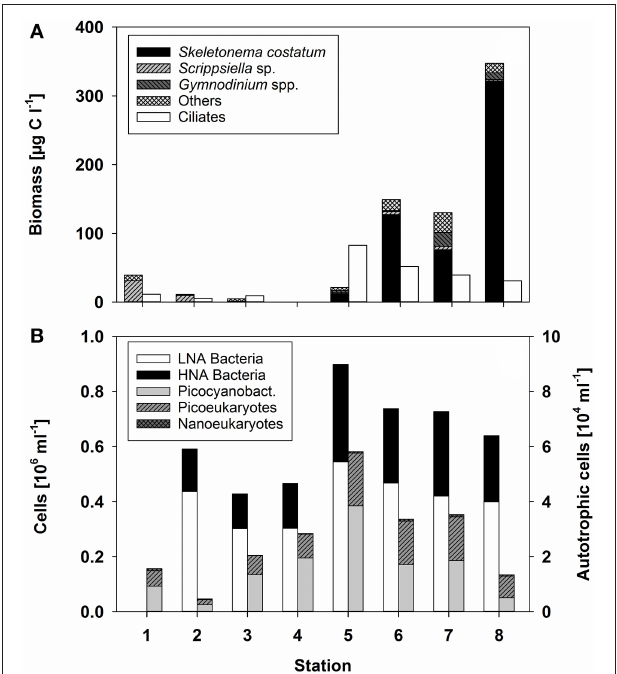
FIGURE 2 | (A) Biomass of the dominant phytoplankton taxa or taxonomic groups, as well as that of ciliates ( µ g C L − 1 ) according to the different stations. No data were obtained for station 4. (B) Bacterial abundance (10 6 mL − 1 ) at the different stations. Heterotrophic bacteria were distinguished according to their low and high nucleic acid (LNA and HNA) content. Autotrophic cells, determined by flow cytometry, are divided into Synechococcus , picoeukaryotes, and nanoeukaryotes (gray bars).